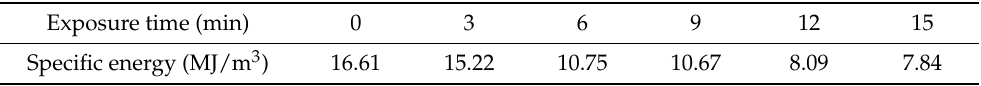
Table 8. The specific energy of rolling force at different microwave exposure times.